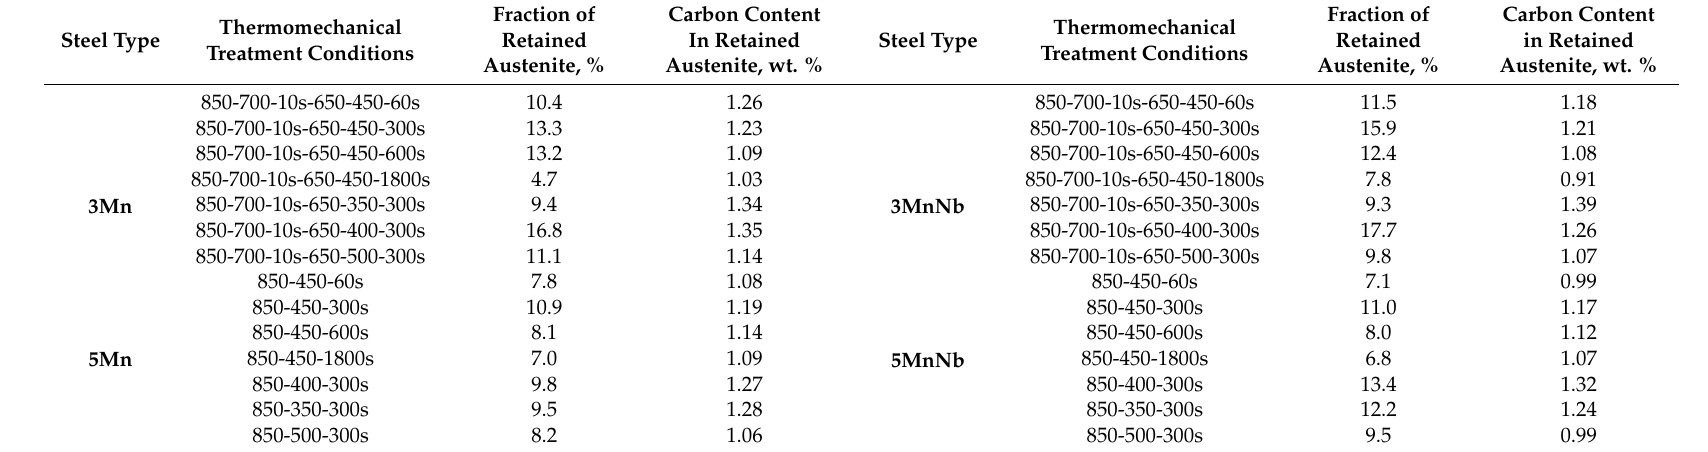
Table 3. Fraction of retained austenite and carbon content in this phase for different variants of thermomechanical